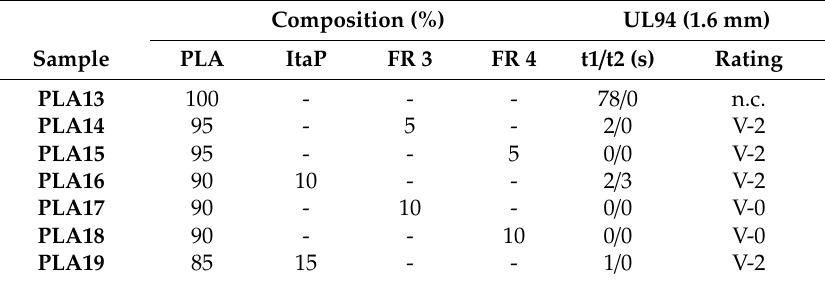
Table 4. UL94 Classification of the PLA composites with higher